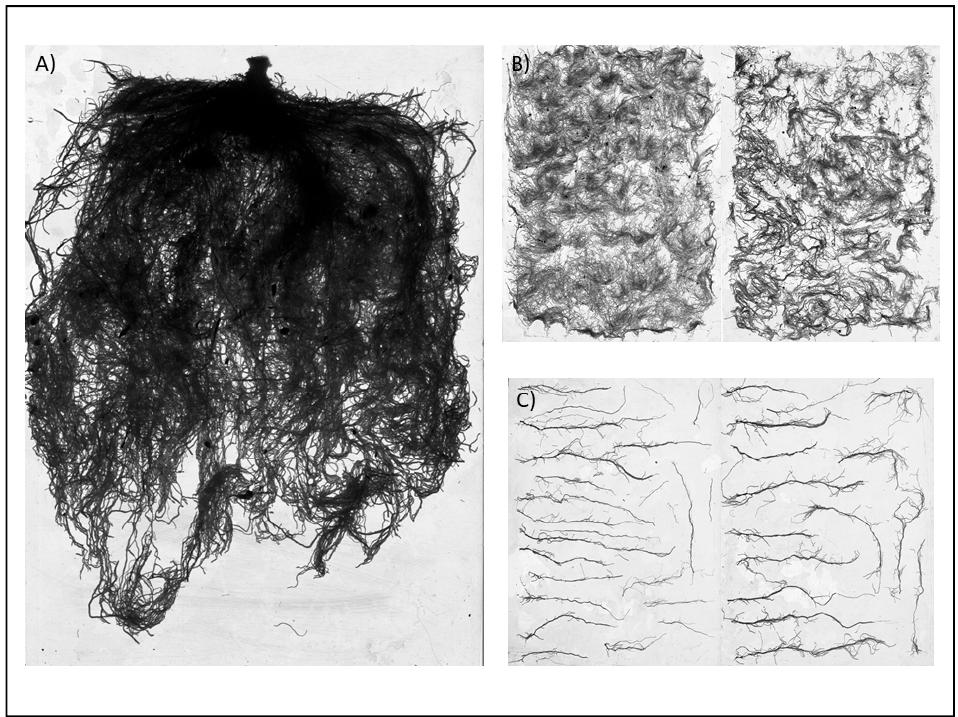
Figure 1. Illustration of the roots along the scanning process (from a representative sample). Individual root systems were separated from the soil with running tap water and taken to the laboratory to be scanned and dried. In Trial 1, whole roots ( A ) were separated into ( B ) root hairs (Ø < 0.5 mm) and ( C ) lateral roots (Ø > 0.5 mm). Root hairs ( B ) were only weighed while lateral roots ( C ) were scanned and weighed. In Trial 2, whole roots ( A ) were also separated into root hairs ( B ) and lateral roots ( C ) and both were scanned and